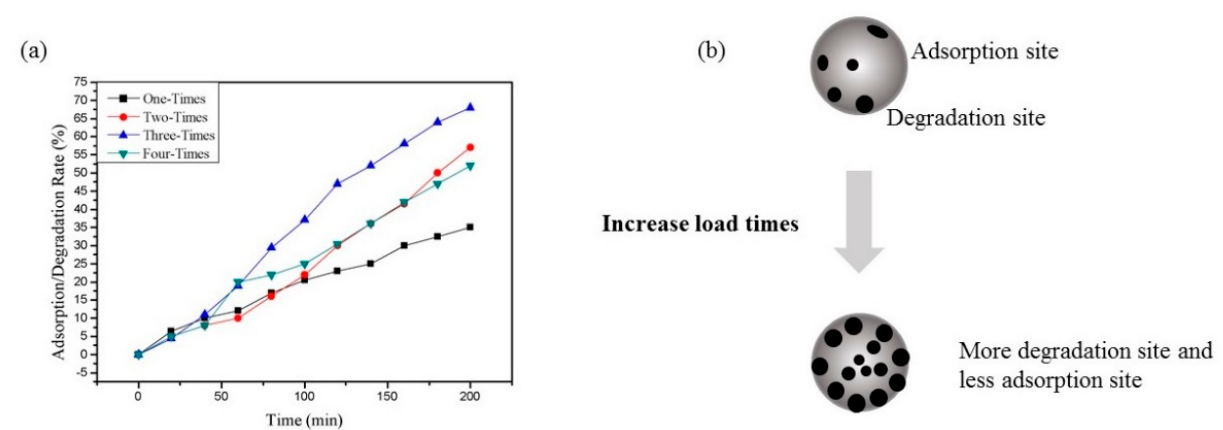
Figure 10. Influence of load times on photocatalytic removal of rhodamine B: ( a ) effect of TiO 2 load times on the RhB (c = 200 mg/L) removal of the TiO 2 @CNF Aerogels, and ( b ) schematic diagram of the influence of different load times on pore structure.